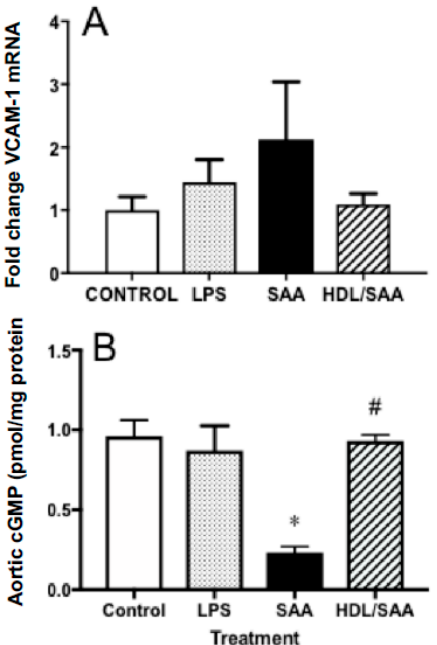
Figure 3. Pretreatment with HDL inhibited SAA-mediated endothelial dysfunction in ApoE − / − mice. Male ApoE − / − mice were randomly allocated into 4 treatment arms and administered with vehicle